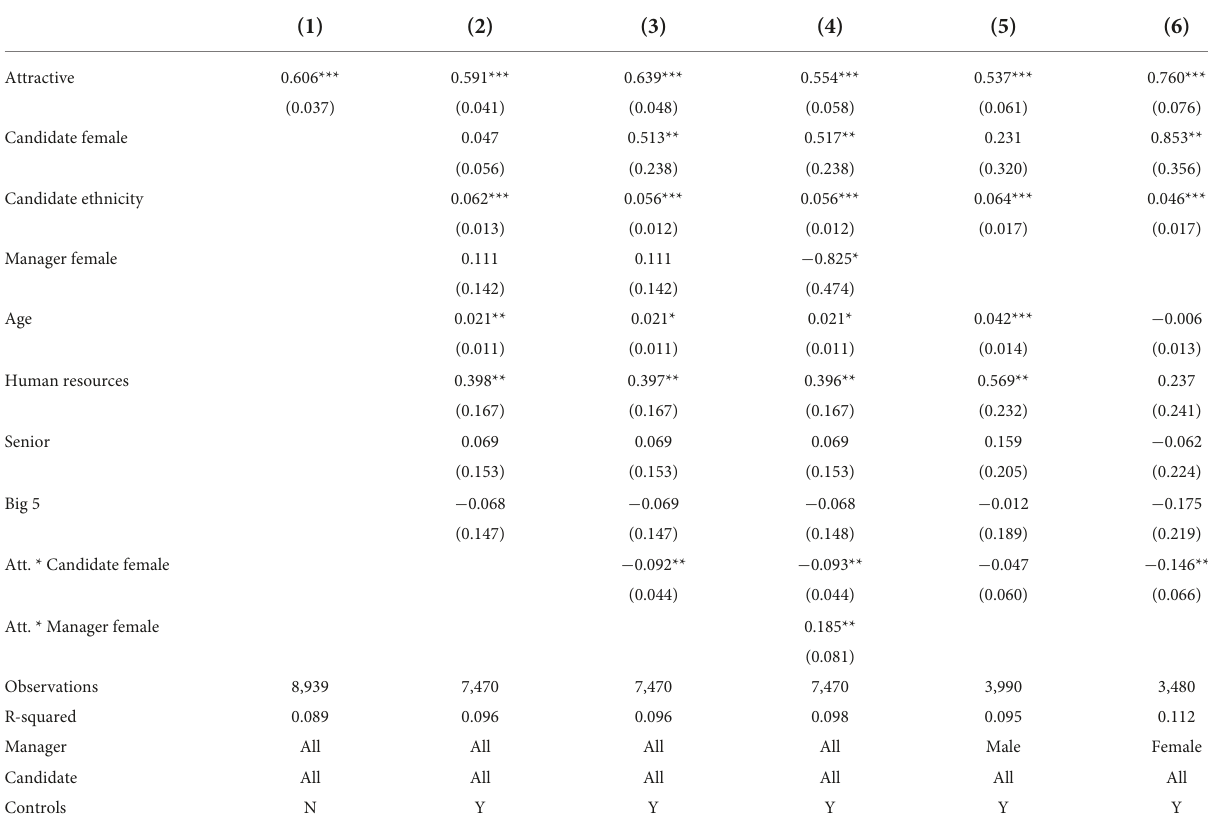
TABLE 3 The effect of attractiveness on the tendency to hire a